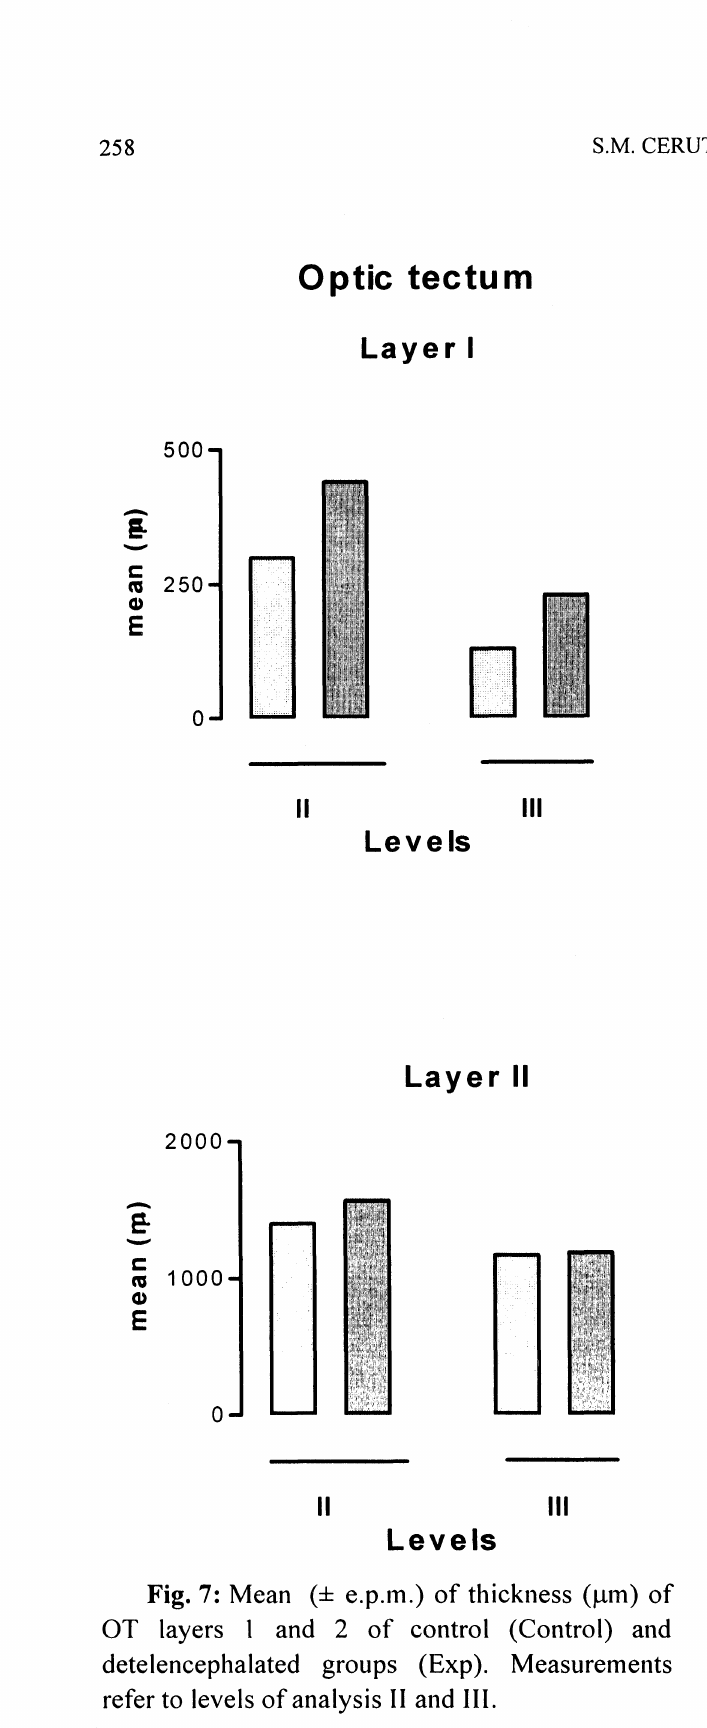
Fig. 7: Mean (+/- e.p.m.) of thickness (tm) of OT layers and 2 of control (Control) and detelencephalated groups (Exp). Measurements refer to levels of analysis II and